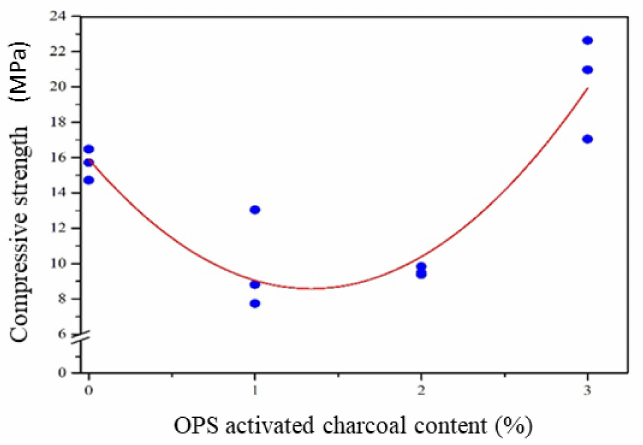
Figure 6. The compressive strength of the mortar with OPS-activated carbon